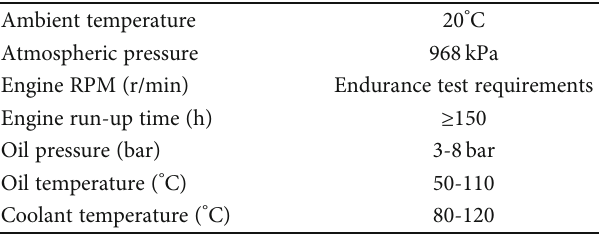
Table 4: Engine test conditions.